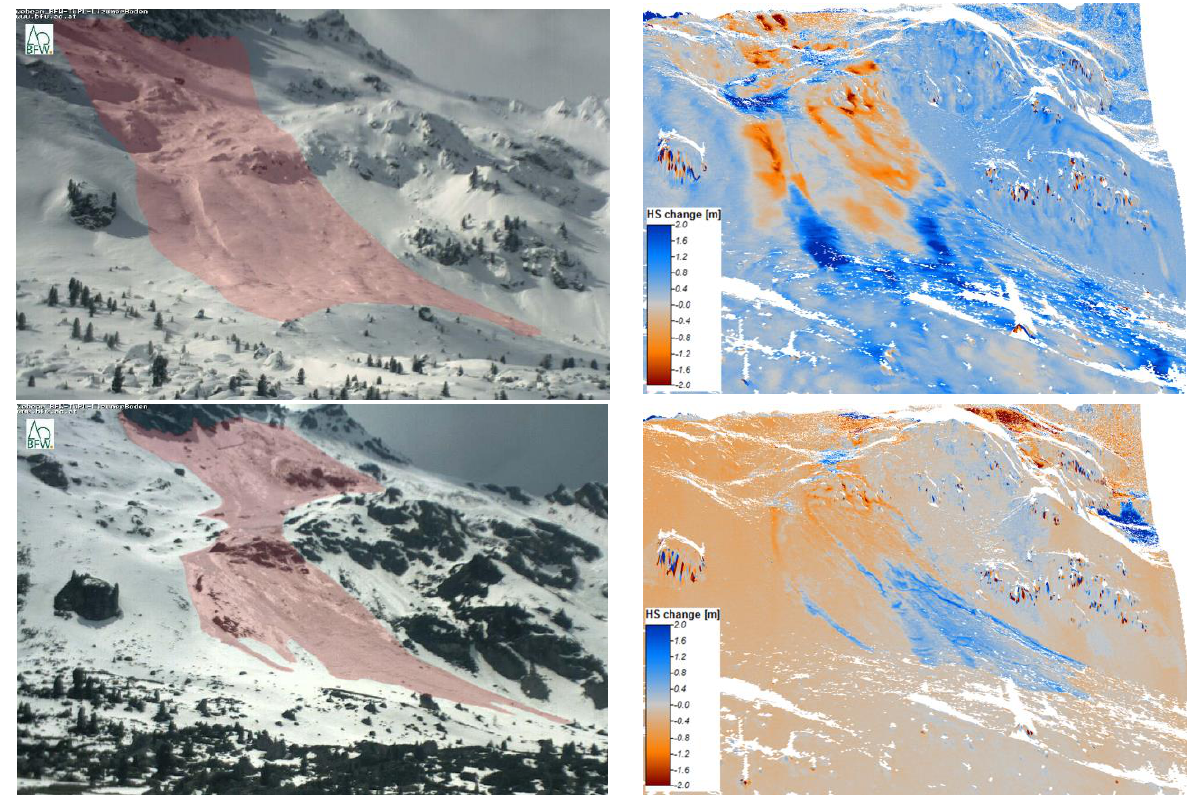
Figure 2. Two avalanche events recorded by the webcam (left column, process area highlighted in red) and ATLS (right column, 3D- view of HS-change before / after event; orange = HS net loss, blue = HS net